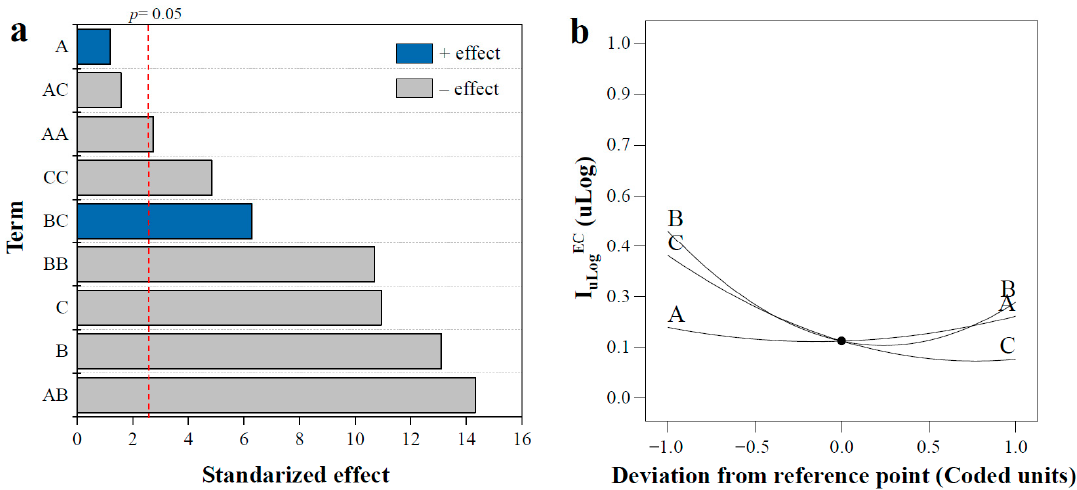
Figure 4. ( a ) Pareto chart showing the standardized e ff ects of variables (first order, quadratic and interaction terms) on I uLogEC (vertical line represents the 95% confidence interval), and ( b ) Perturbation graphs for I uLogEC (A-[H 2 O 2 ] / [Fe 2 + ], B-[Fe 2 + ],